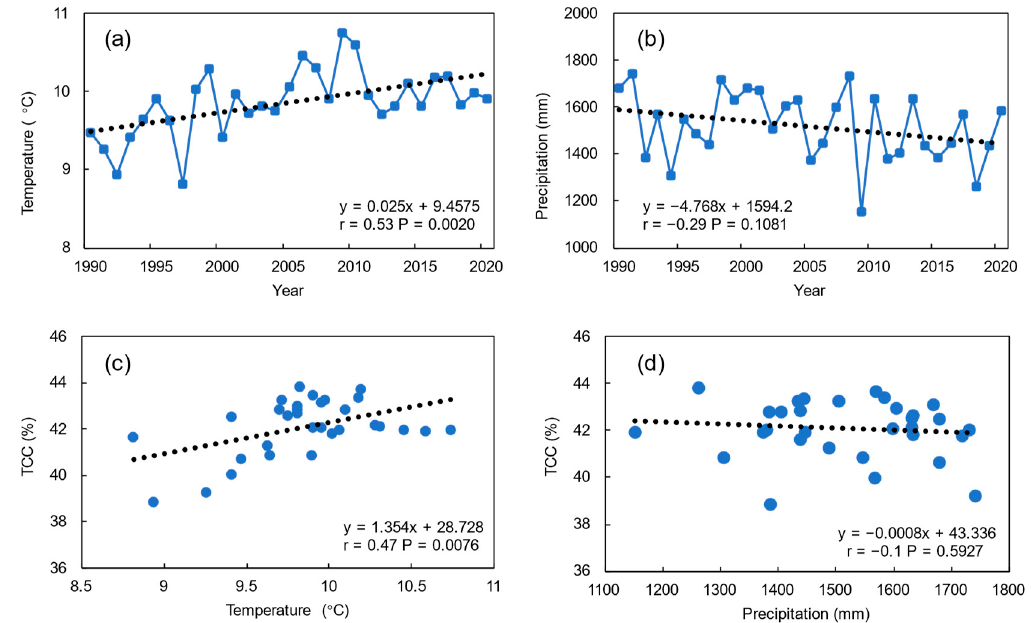
Figure 17. Annual mean temperature ( a ) and annual precipitation ( b ) from 1990 to 2020 of the for ‐ ests in the Eastern Himalayas; correlations of the TCC estimations against ( c ) annual mean tem ‐ perature and ( d ) annual